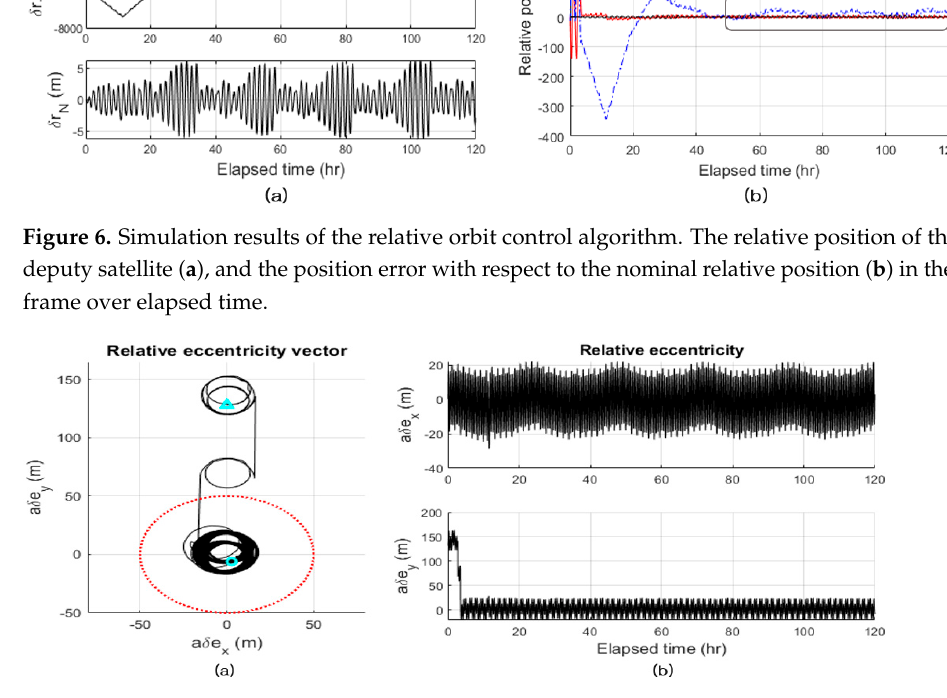
Figure 6. Simulation results of the relative orbit control algorithm. The relative position of the trail deputy satellite ( a ), and the position error with respect to the nominal relative position ( b ) in the RTN frame over elapsed time.